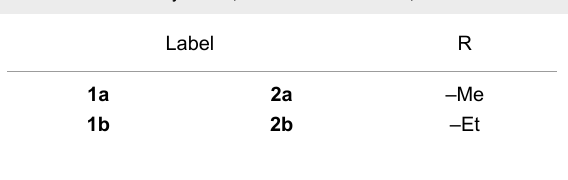
Table 1: Chloroaldehydes 1a,b and chloronitriles 2a,b